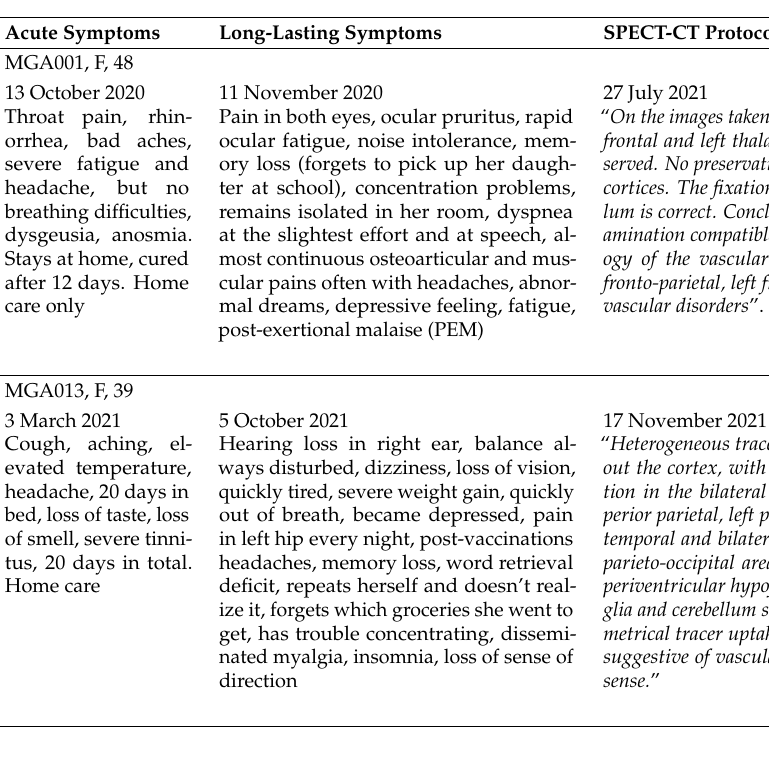
Table 4. Patients MGA001 & MGA013 with clinical PACS. Age, sex, date of acute COVID-19, date of suspicion of PACS diagnosis, date of first SPECT-CT, EMRs notes, SPECT-CT protocols (Courtesy of Drs Bouazza and Mahy, Vesalius Hospital, ISPPC,